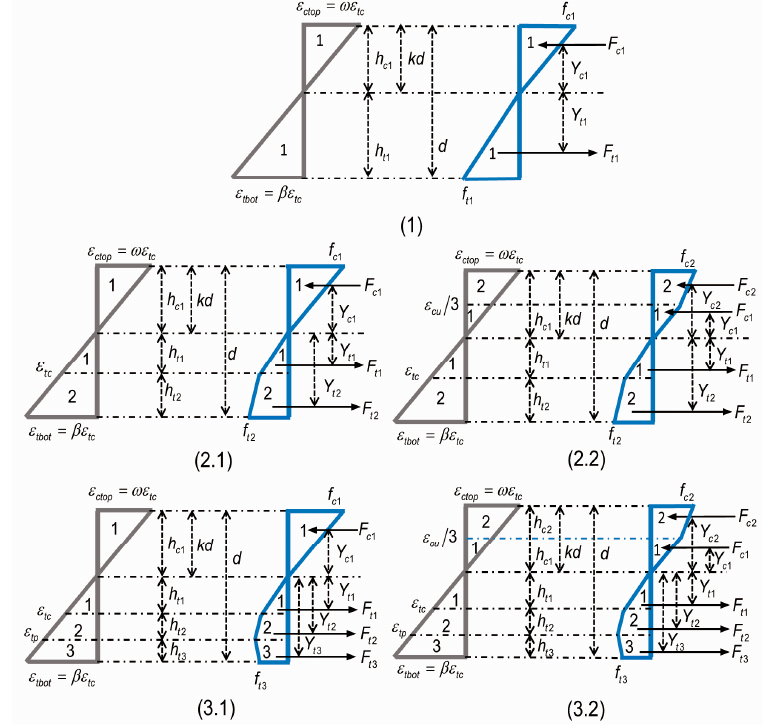
Figure 5. The strain and stress distributions for the different stages with applied normalized tensile strain at the bottom fiber (β) .